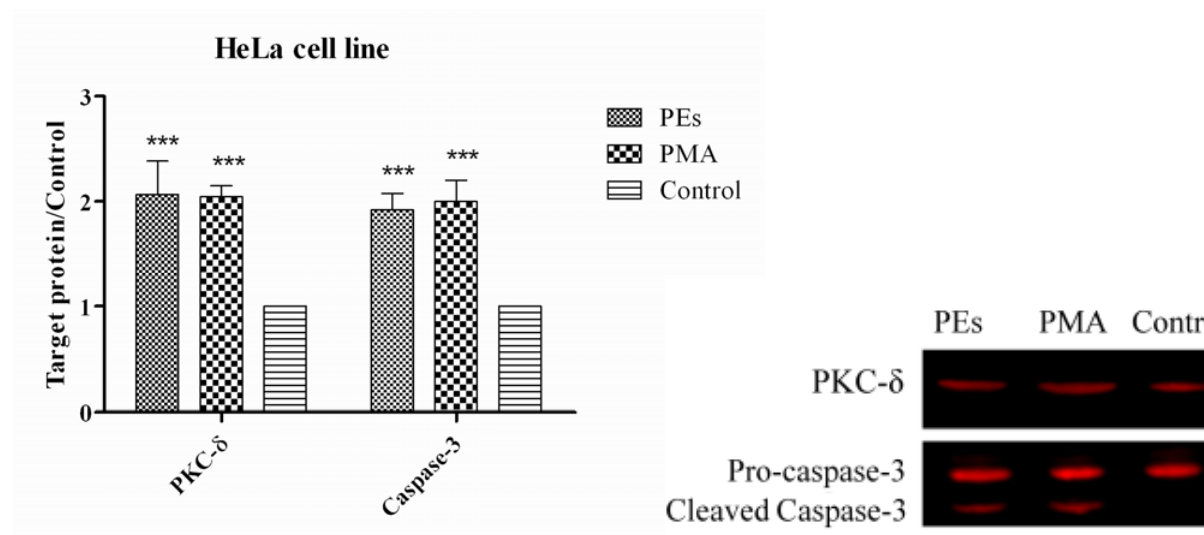
Figure 8. Expression of PKC- δ and Caspase-3 proteins in treated and un-treated HeLa cell line. Cells were treated with isolated PEs from Jatropha meal and PMA at the IC concentration incubated for 24 h. Equal amounts of total cellular protein of treated and un-treated cells were subjected to Western blot analyses for PKC- δ , Caspase-3 and GAPDH protein expression. All values represent mean ± standard error from three independent experiments, *** p ≤ 0.001 and ** p ≤ 0.01indicate significant difference compared to the untreated